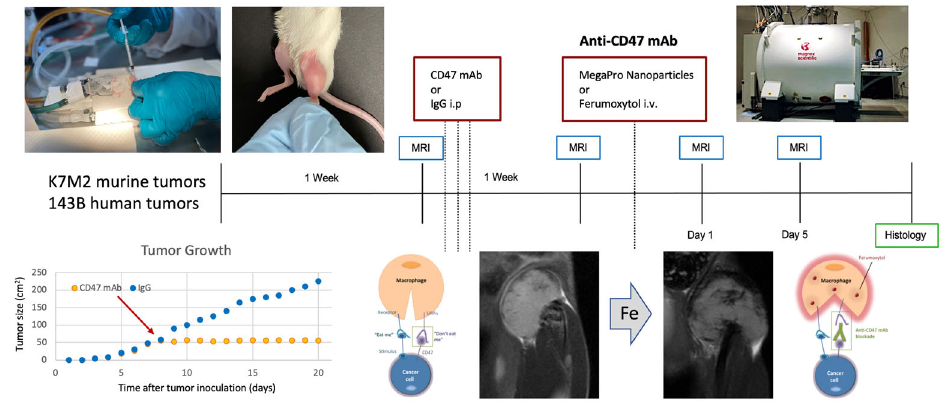
Figure 4. The Stanford co-clinical trial design.